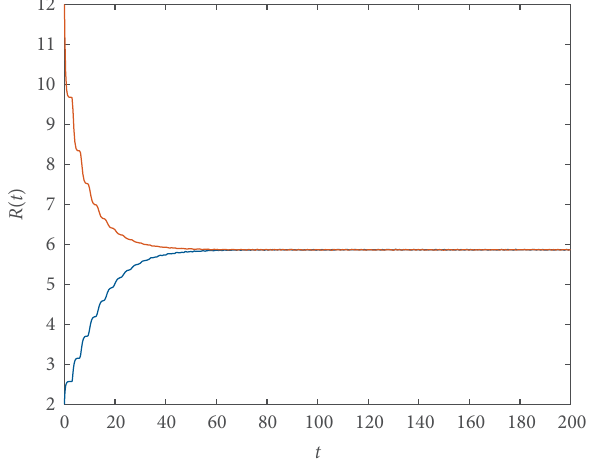
. Figure 3: Asymptotic behavior of 휏 = 3, ̃휎 = 6, 훽 = 2,푅 0 = 12, 50.